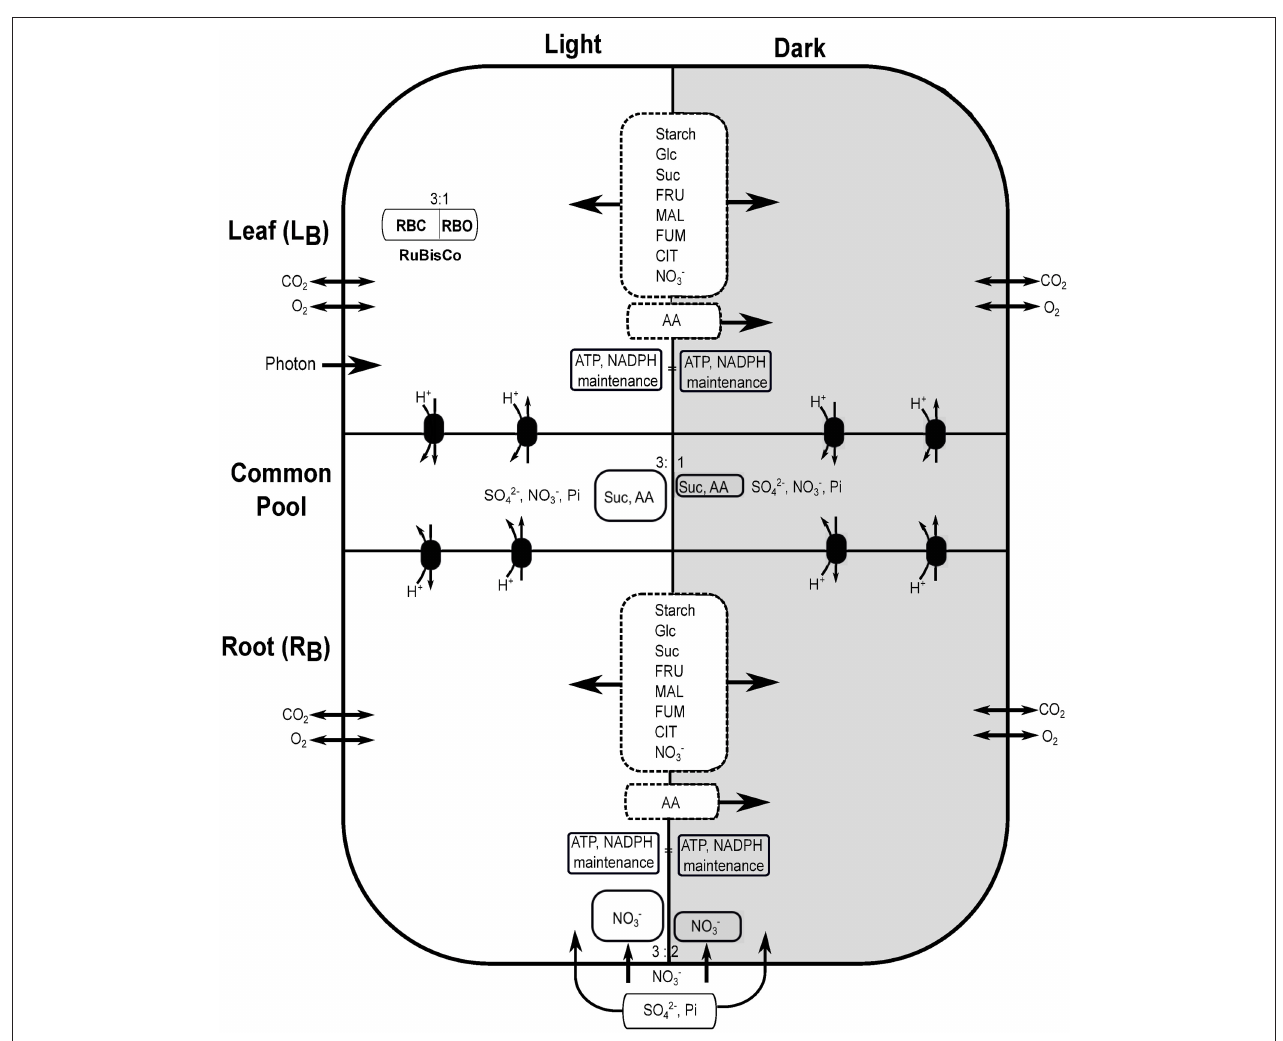
FIGURE 1 | Schematic description of diel leaf-root metabolic model of Arabidopsis thaliana . Light and dark phases are represented with white and dark backgrounds, respectively. The ratio of rubisco carboxylase (RBC):oxygenase (RBO) was set to 3:1 in all phases (only leaf in the light is shown). Starch, glucose (Glc), sucrose (Suc), fructose (FRU), malate (MAL), fumarate (FUM), citrate (CIT), and nitrate (NO − 3 ) were allowed to accumulate in the light and dark phases of leaf and root (dashed rectangle between light and dark where arrows indicate bidirectional storage). AA represents the 18 different amino acids. AA can be stored in the light and utilize in the dark. Exchange of AA, Suc, sulfate (SO 2 − 4 ), nitrate and phosphate (Pi) were allowed between leaf and root through the common pool using an active proton pump. Nitrate and photon uptake were allowed through root and leaf, respectively, at a maximum rate quantified by the corresponding tissue biomass. Uptake of other mineral nutrients (SO 2 − 4 , Pi, etc.) were allowed only through the root. Gaseous exchange of CO 2 and O 2 were allowed in all four